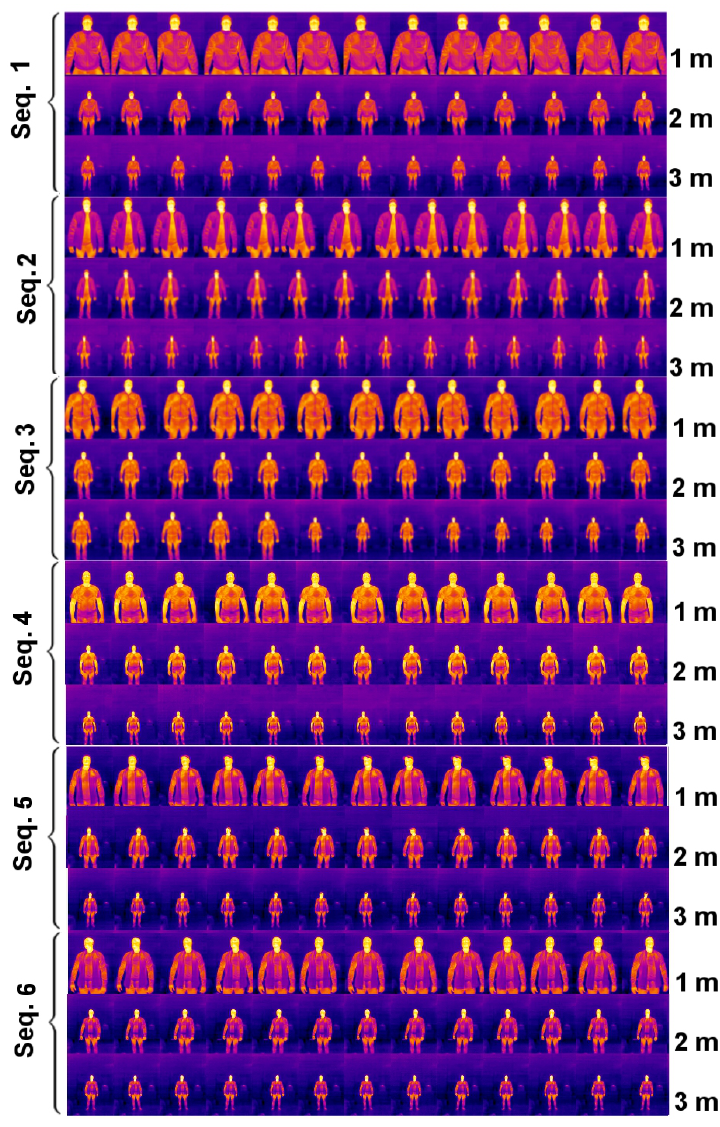
Figure 7. Sample frames from test set (1, 2, 3, 4, 5, 6) at different distances (1, 2, 3